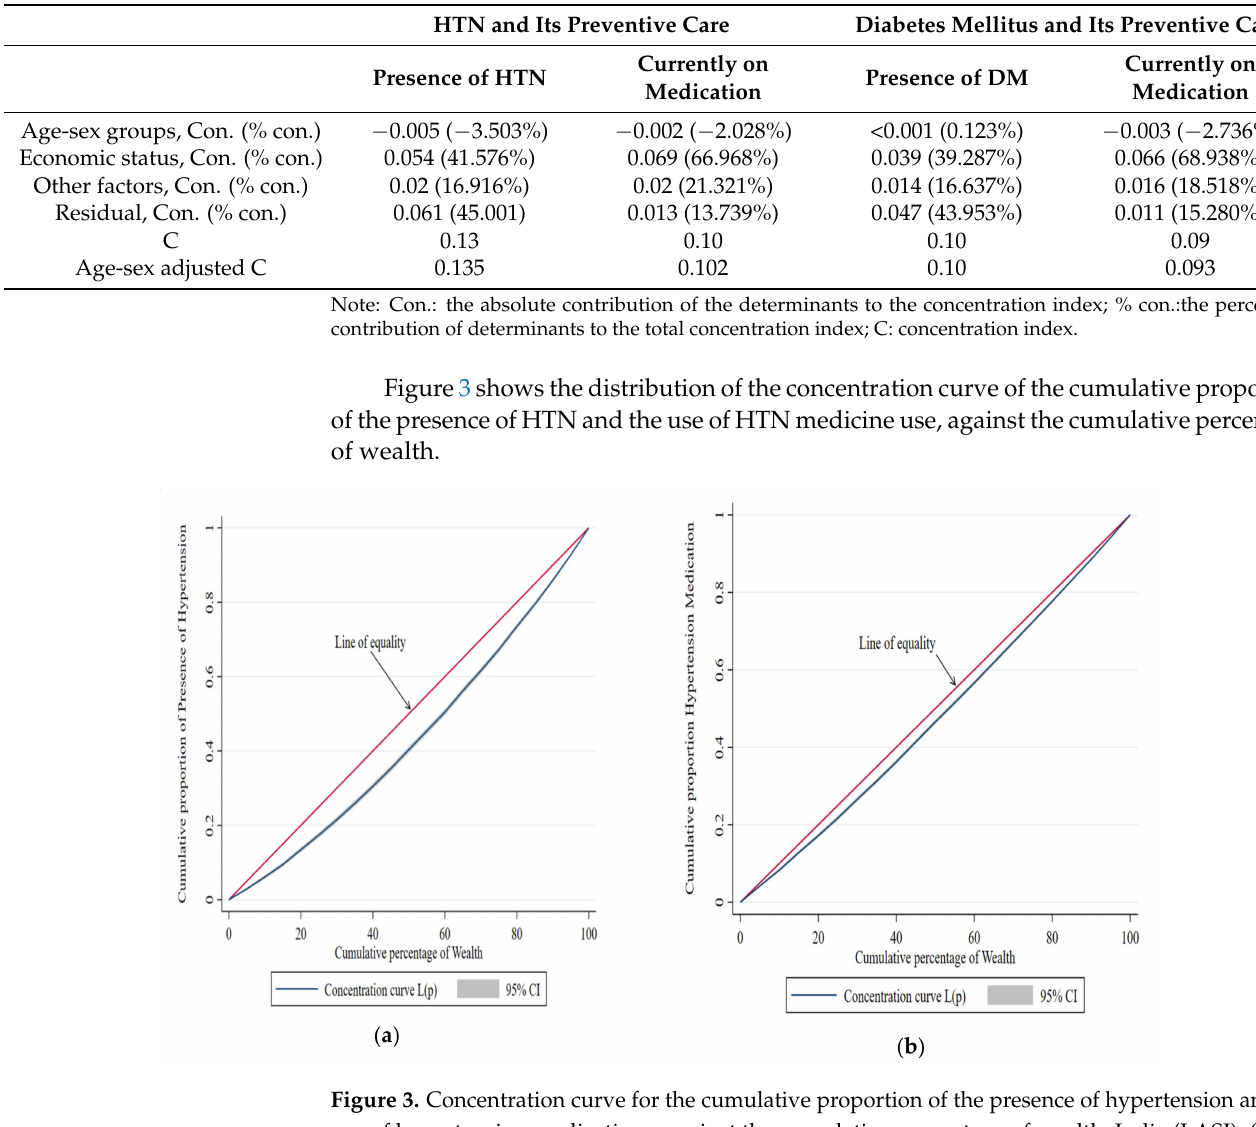
Table 4. Description of factor contributions and age-sex-adjusted Cs.